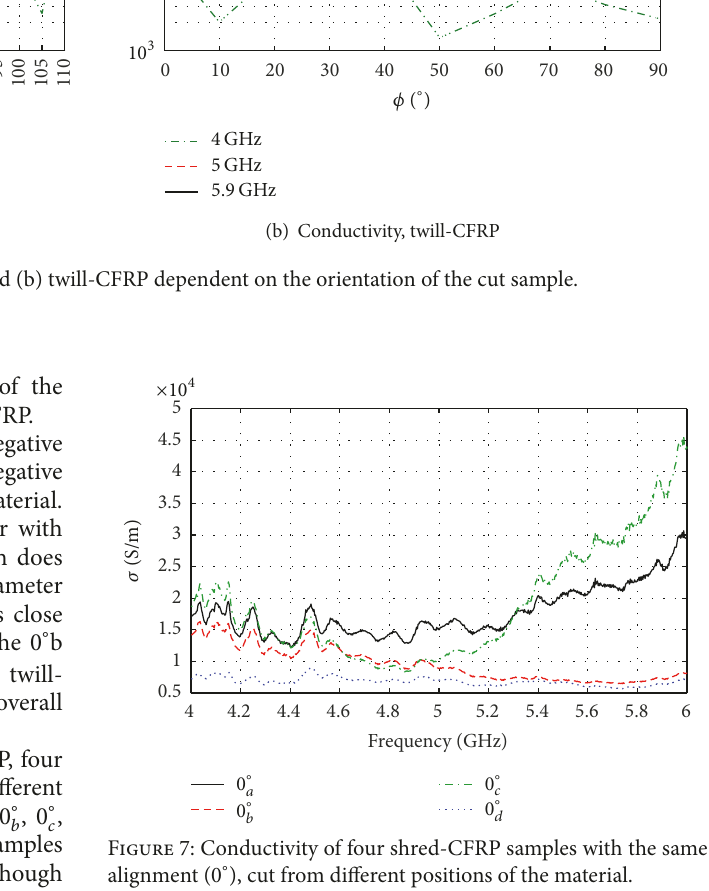
Figure 7: Conductivity of four shred-CFRP samples with the same alignment ( 0 ∘ ), cut from different positions of the